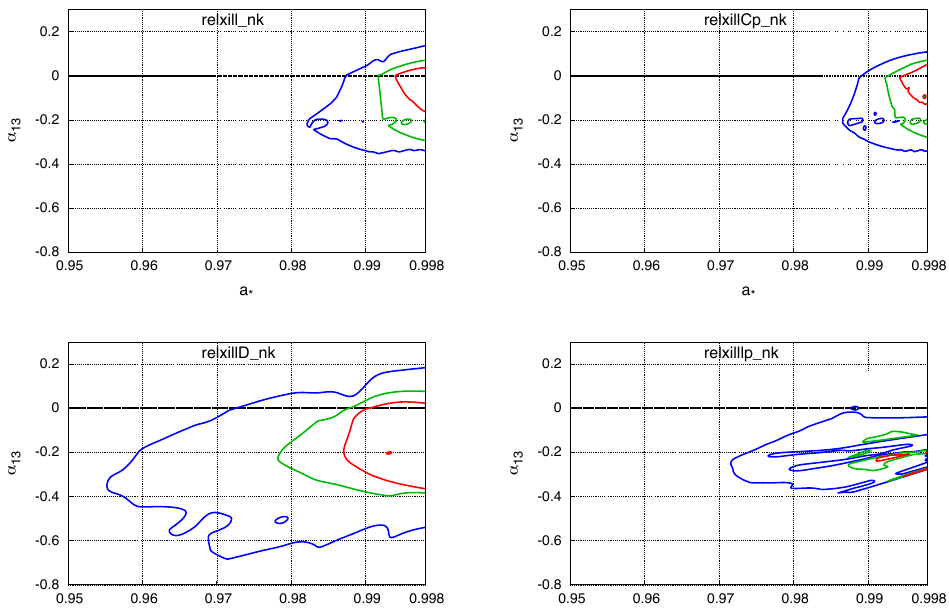
Figure A6. Constraints on the spin parameter a ∗ and the Johannsen deformation parameters α 13 for 1H0419–577 when the reflection component is modeled by RELXILL _ NK ( top left panel ), RELXILL C P _ NK ( top right panel ), RELXILL D_ NK ( bottom left panel ), and RELXILLLP _ NK ( bottom right panel ). The red, green, and blue curves are, respectively, the 68%, 90%, and 99% confidence level boundaries for two relevant